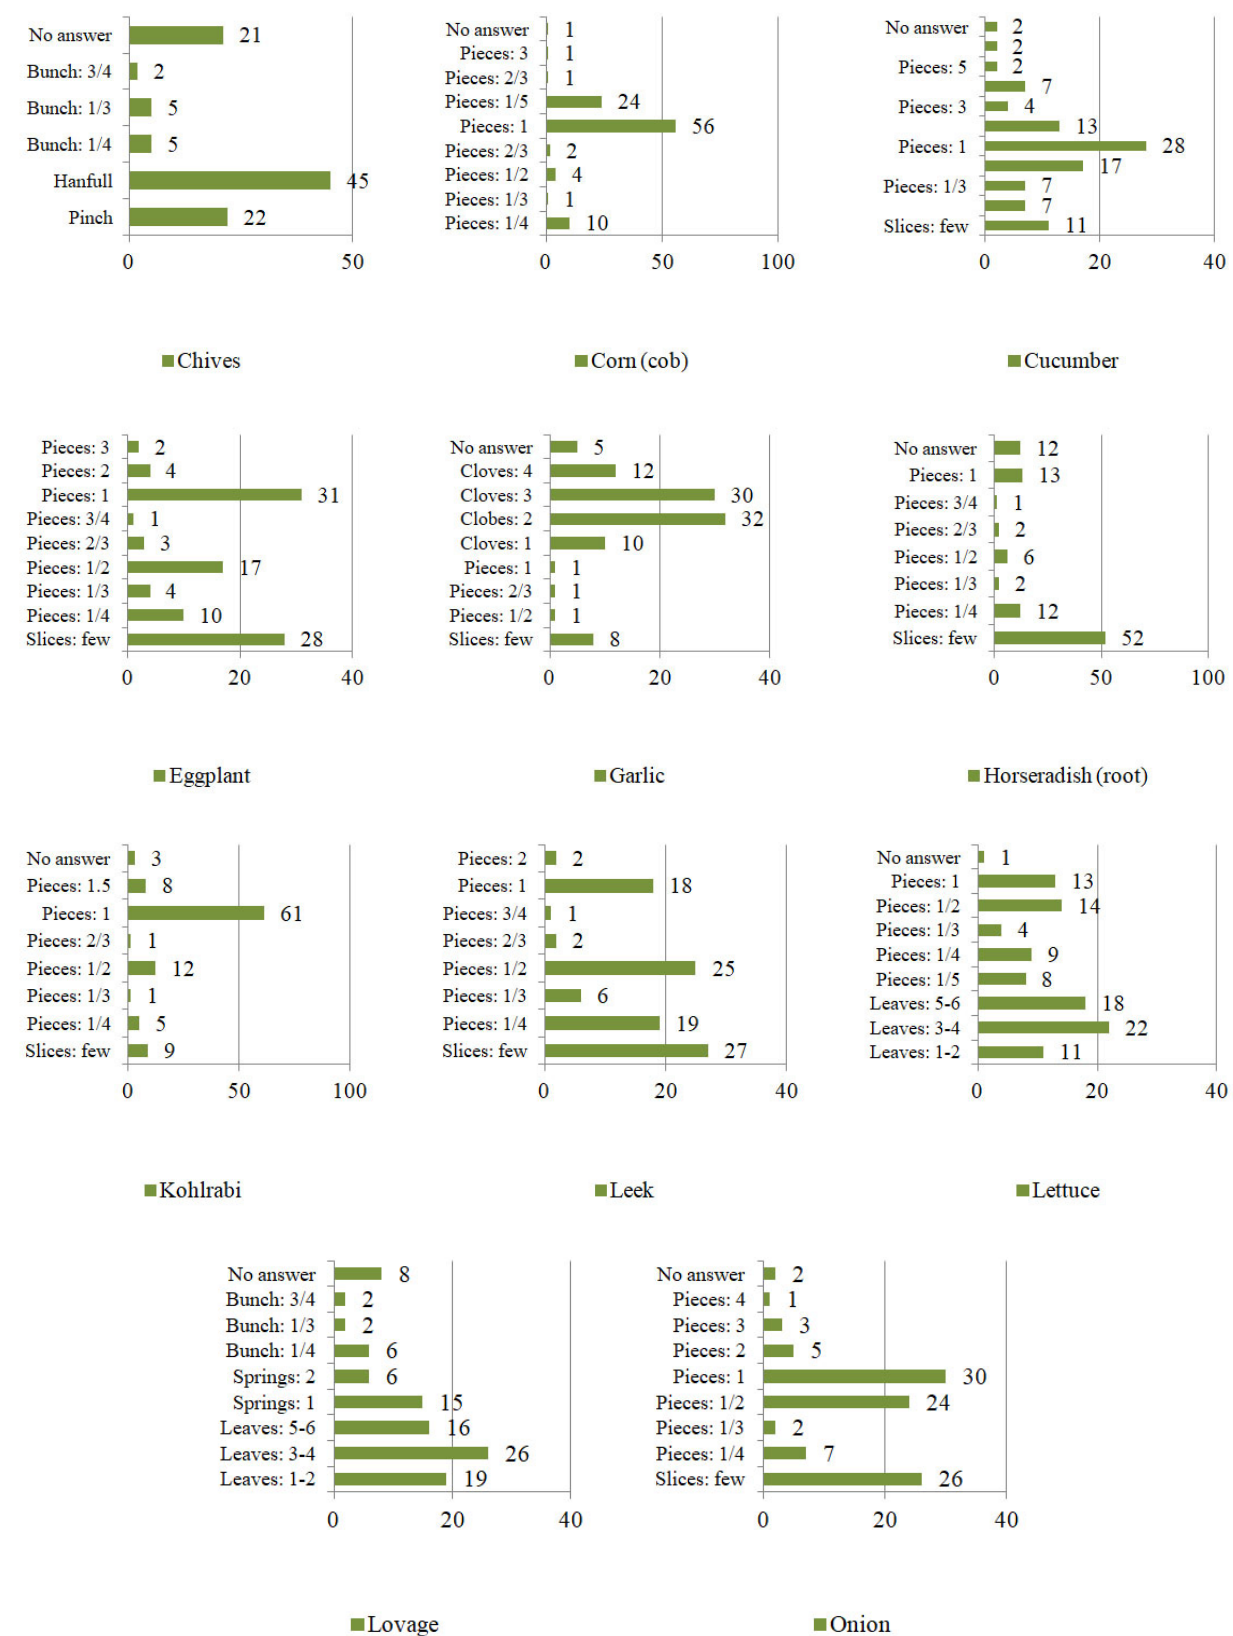
Figure 8. The quantity of vegetables consumed at one sitting by Poles [%] continued.